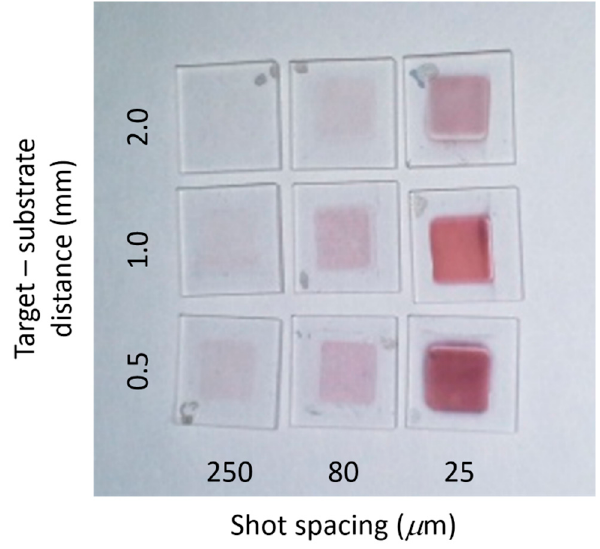
Figure 6. Photograph of the nanoparticle (NP) films deposited at different values of target-substrate separation and laser shot spacing.